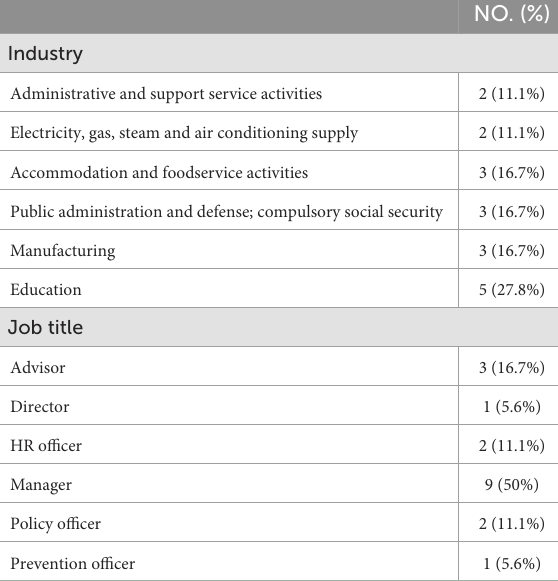
TABLE 1 Characteristics of participants ( n = 18). TABLE 2 Criteria used to assign ratings to the constructs, based on